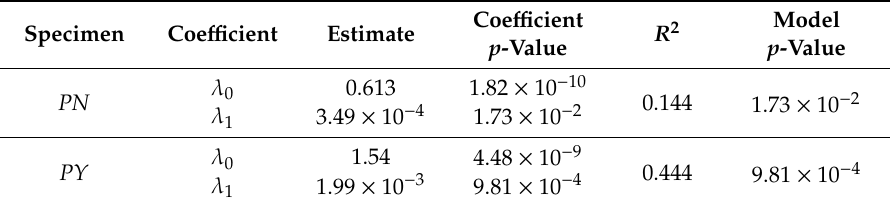
Figure 7. Modal parameters with linear regression fitting lines. Table 6. Linear regression parameters.